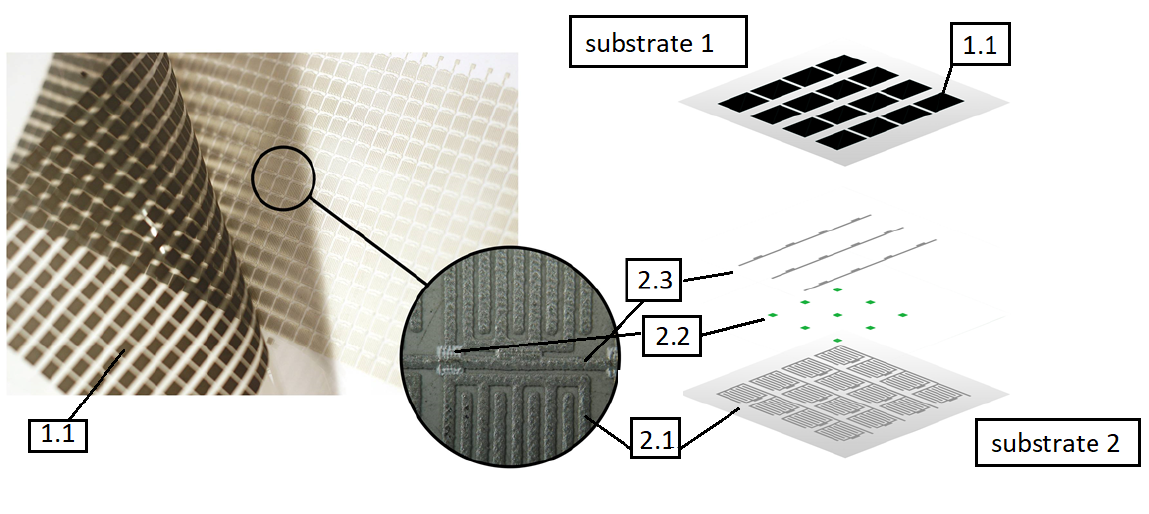
Figure 2. Single robotic skins’ layer—the FSR matrix real view (left) and diagram (right); 1.1—resistive layer on substrate 1; on substrate 2: 2.1—comb electrodes; 2.2—dielectric separators; 2.3—paths connecting sensors in